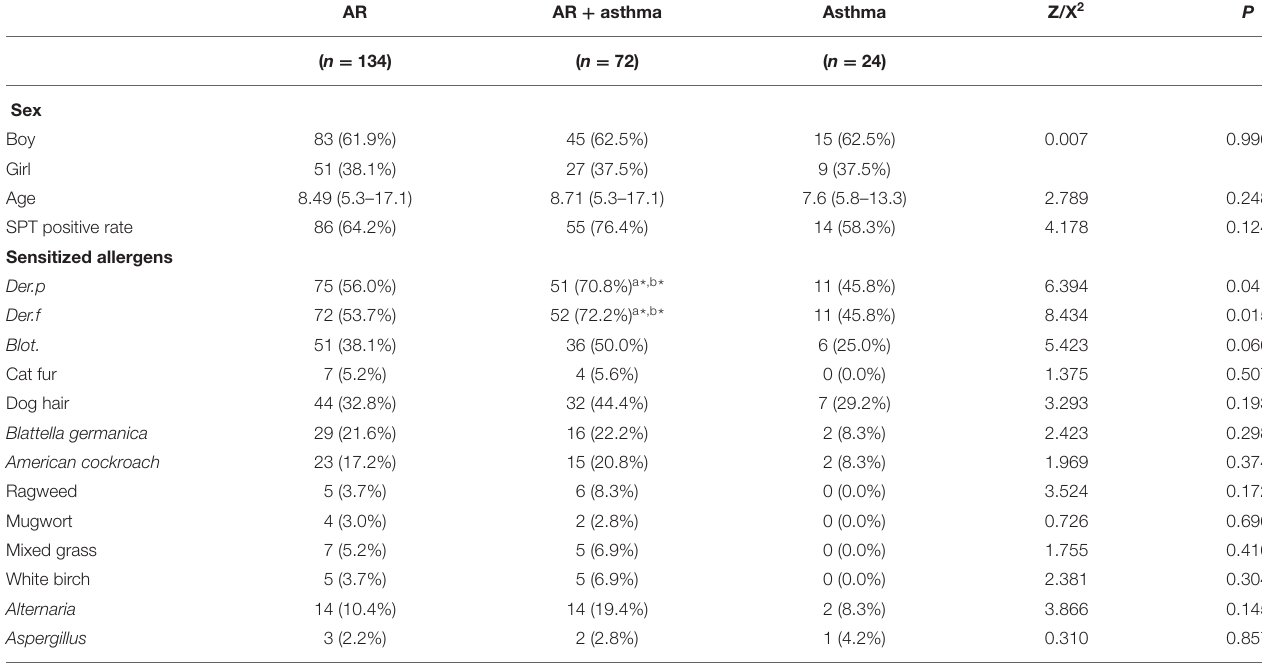
Der.p, Dermatophagoides pteronyssinus; Der.f, Dermatophagoides farinae; Blot., Blomia tropicalis. Data are presented as number (percentage). * P < 0.05. a Compared between AR group and AR combined with asthma group. b Compared between AR combined with asthma group and asthma